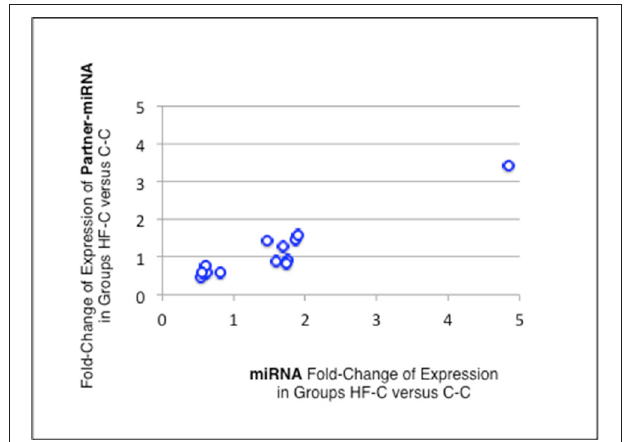
FIGURE 7 | miRNA and partner-miRNA differential expression in groups HF-C vs. C-C. Thirteen miRNAs differentially expressed between groups C-C and HF-C maturated in parallel with the second strand of their RNA duplex precursor (Partner-miRNA). Ratios of HF-C to C-C expressions (Fold-Change of Expression; FCE) are expected to occur with similar levels for a miRNA and its Partner-miRNA. FCEs of miRNA-Partners were plotted against FCEs of miRNAs. Both FCEs displayed high correlation ( R 2 = 0.92).